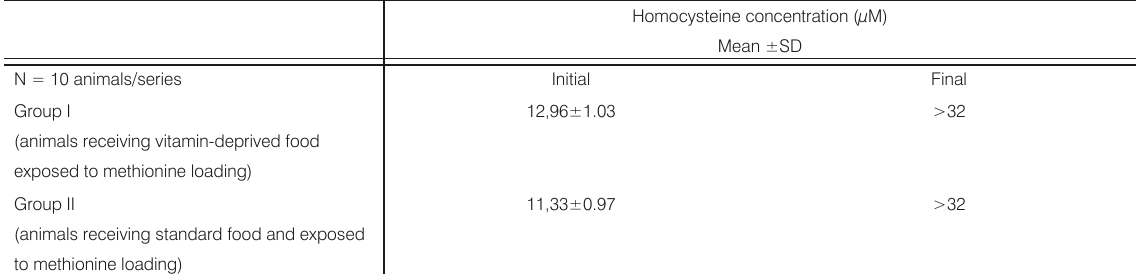
Table 1. Concentration of homocysteine in rat plasma determined initially and after methionine administration for a 15-day period.